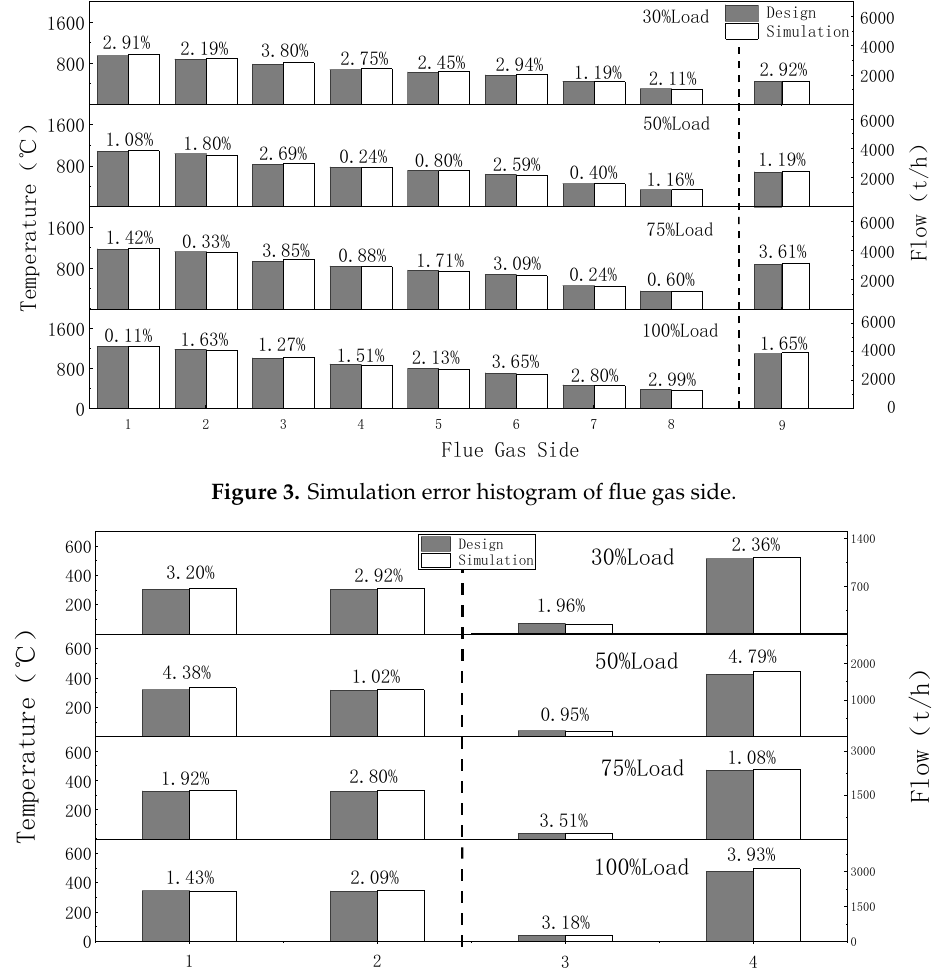
Figure 4. Simulation error histogram of APH.